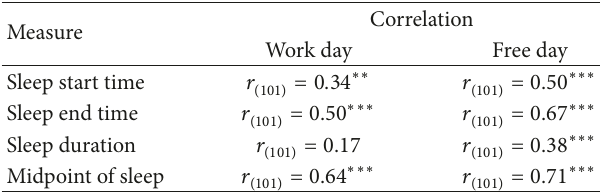
Table 2: Correlation between actigraphic sleep data and self- reported data on the Munich Chronotype Questionnaire